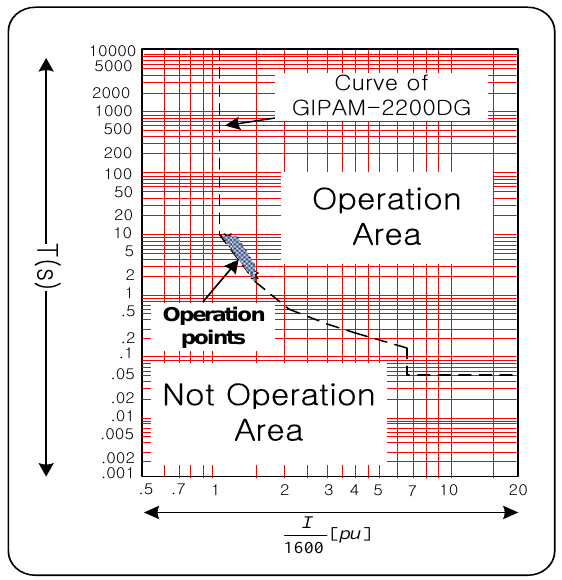
Figure 2. Relay operating points in OCR (over current relay) coordination curve. Table 2. Generator voltages at the time of delay OCR operation.